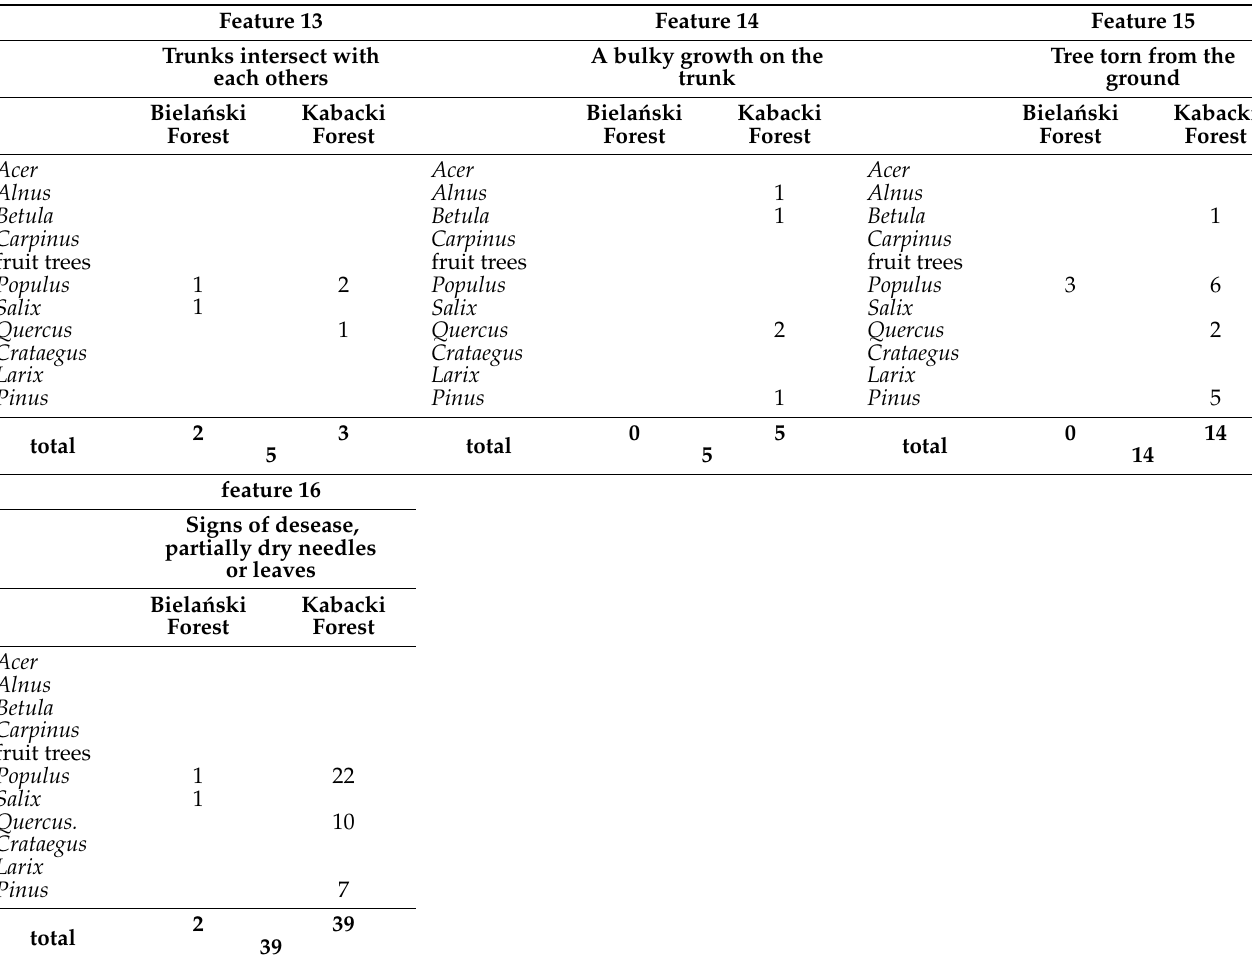
Table A3. Selected defoliated trees of poor health condition (features 13–16) in the Biela´nski Forest and the Kabacki Forest in Warsaw